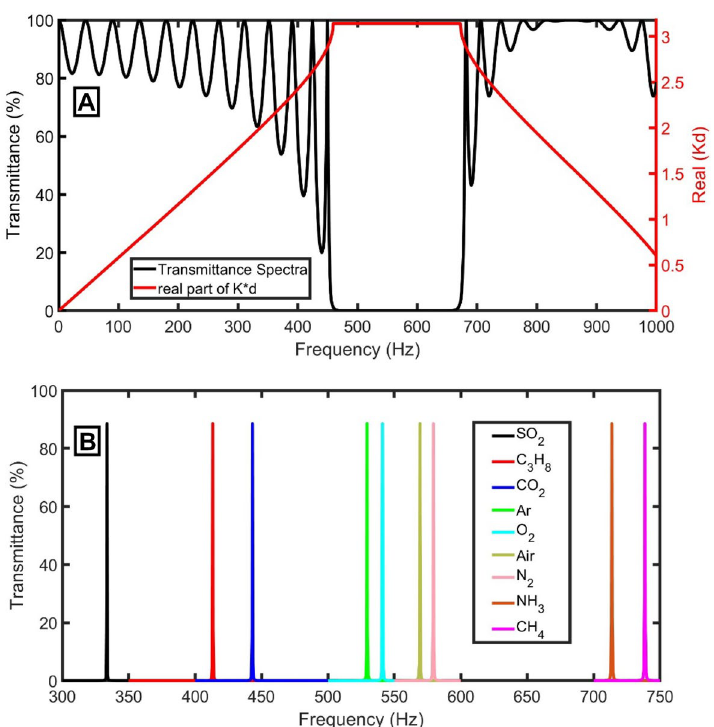
Figure 2. ( A ) The transmittance spectra of the proposed gas sensor without defect (left axis) and the band structure of the real part of the Bloch wavenumber (right axis) using air samples, and ( B ) the defect peaks of different gas samples by using